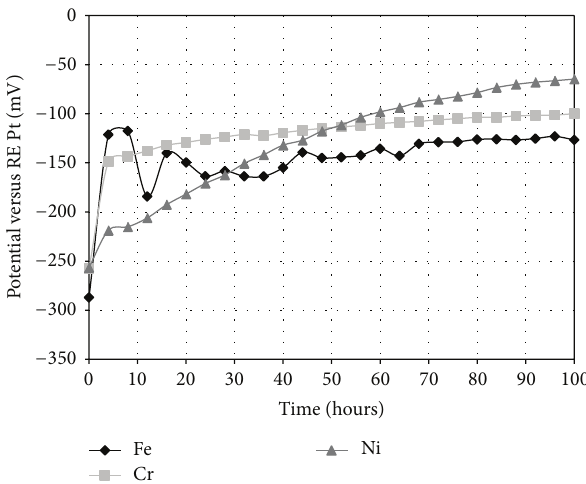
) for Cr, Ni, and Fe corr